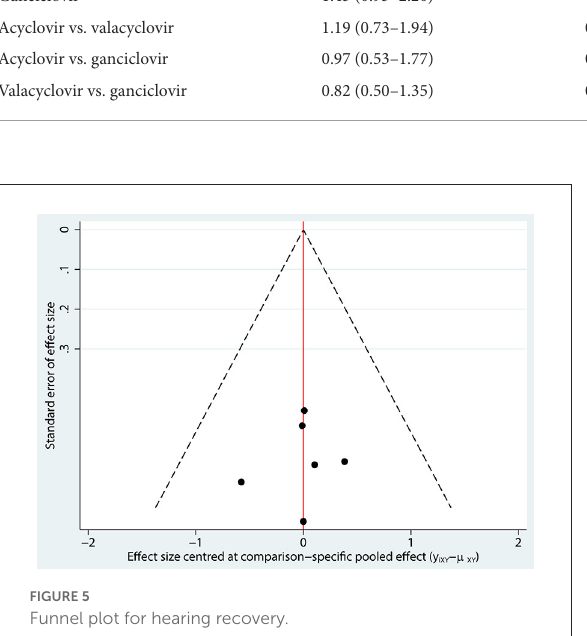
FIGURE5 Funnel plot for hearing